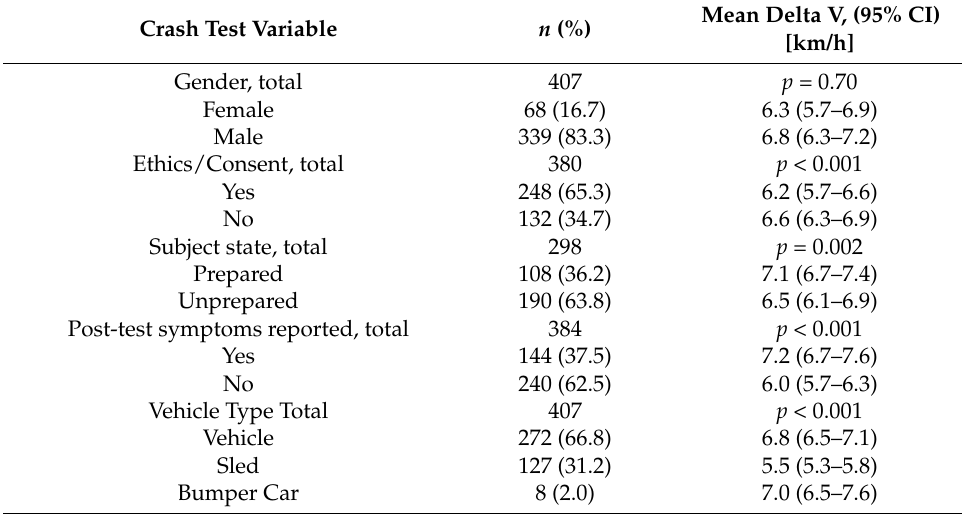
Figure 1. Identification and selection of articles describing rear-impact adult volunteer crash testing. Table 1. Subject demographics and crash test characteristics, vs. test delta